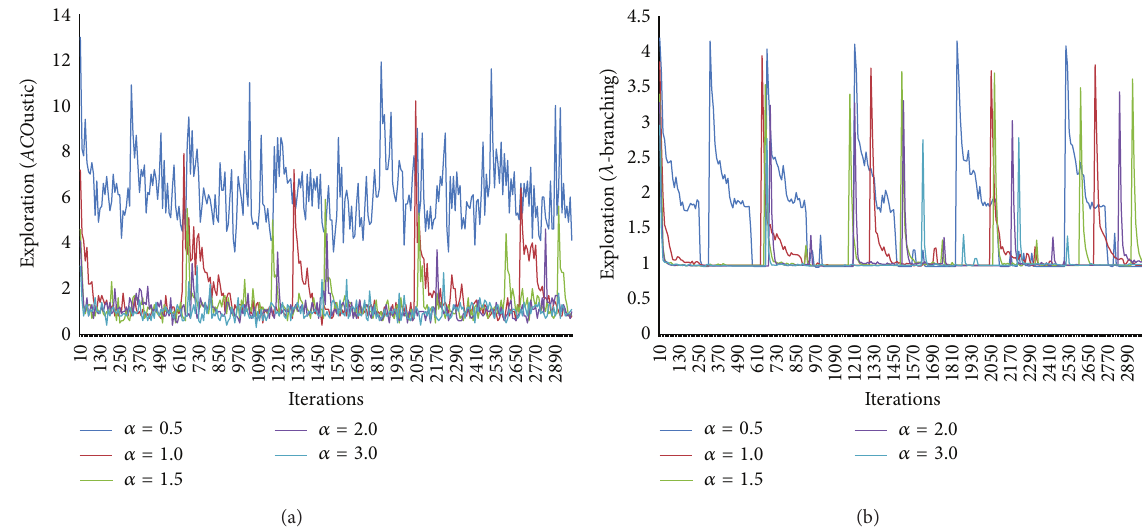
Figure 10: The effect of pheromone intensity (alpha) measured by ACO ustic (a) and measured by 𝜆 -branching